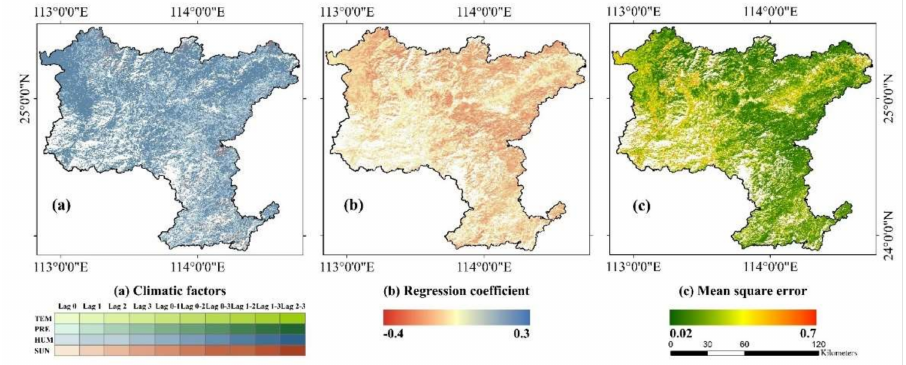
Figure 7. Climate-driving forces behind the EVI changes ( a ), DLM coefficients of the climate fac- tors ( b ), and the mean square error ( c